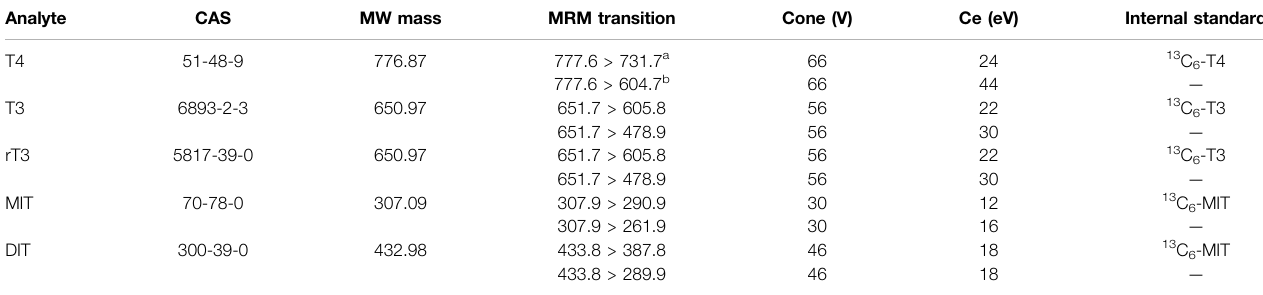
For all the compounds, a The fi rst MRM transition used for quanti fi cation. b The second MRM transition used for veri fi cation.